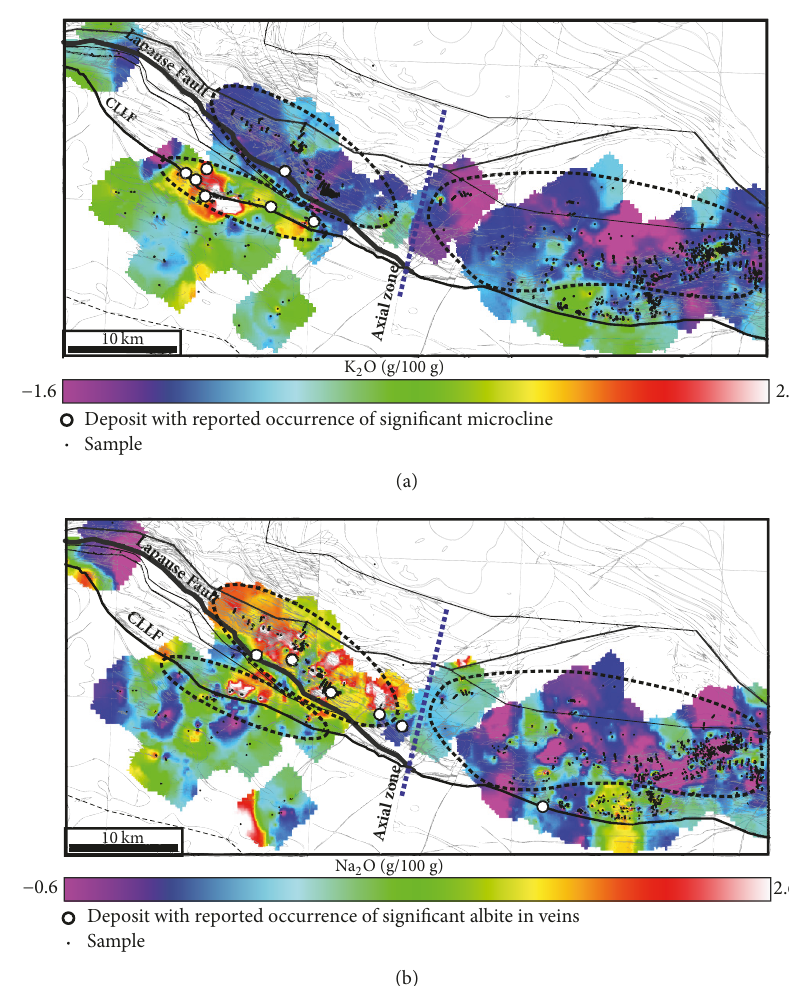
Figure 8: Interpolation of K 2 O and Na 2 O mass balance calculations from the regional lithogeochemistry database for the Malartic, Val-d’Or, and Bourlamaque regions. Interpreted distinct metasomatic fields are delineated by dashed lines. Modified from Rafini [30]. Geological map is in the background (SIGEOM